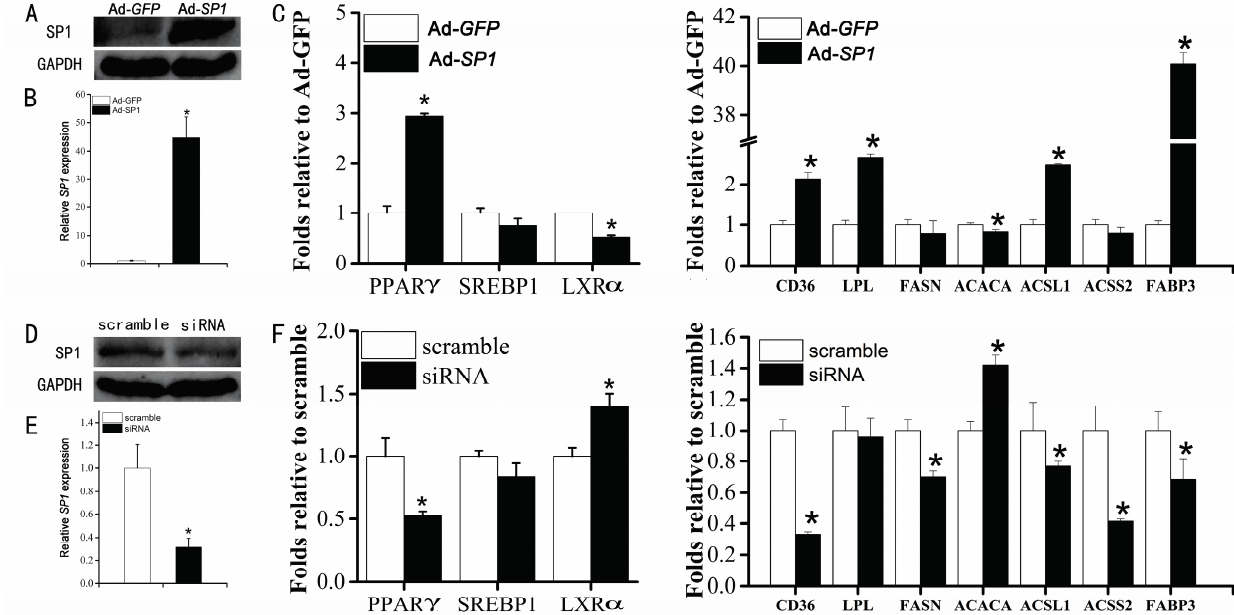
Figure 4. Effect of expression alteration of SP1 on the expression of genes relative to lipid metabolism. ( A ) Ad- SP1 overexpressed the expression level of SP1 protein; ( B ) Ad- SP1 overexpressed the mRNA expression level of the SP1 gene; ( C ) Overexpression of SP1 epithelial cells (GMECs); ( D ) siRNA decreased the protein expression of SP1; ( E )